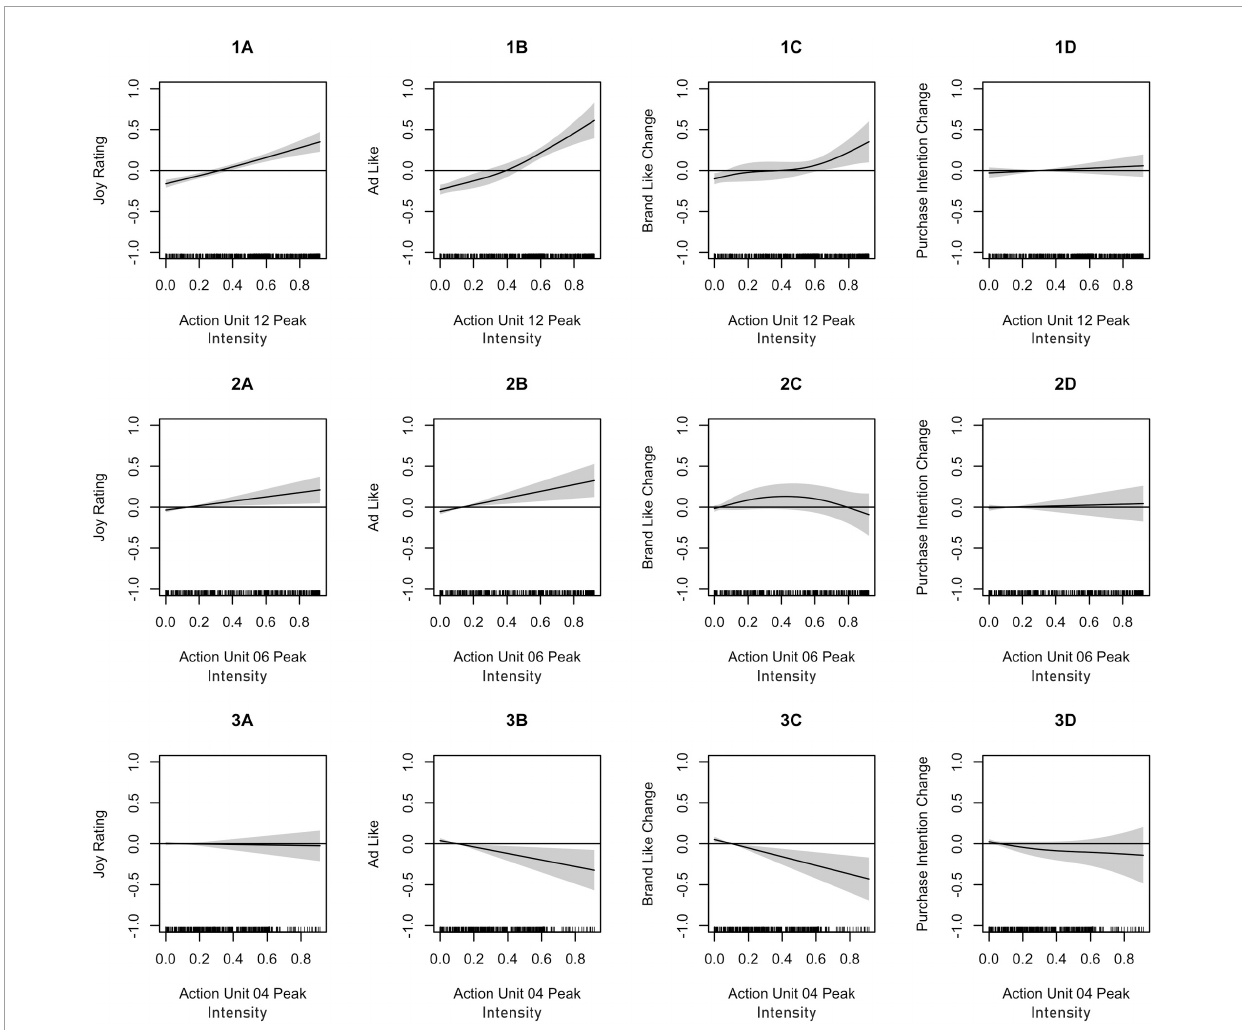
FIGURE3 Fitted smooth main effects model for Action Unit peaks of AU12 [lip corner pull, (1A–1D) ], AU06 [cheek raiser, (2A–2D) ], and AU04 [brow raiser, (3A–3D) ]. The graphs show the estimated marginal effects on joy ratings (A) , advertisement likeability (B) , brand likeability change (C) , and purchase intention change (D) . The effects are centered around zero. The shaded areas show 95% pointwise confidence intervals.